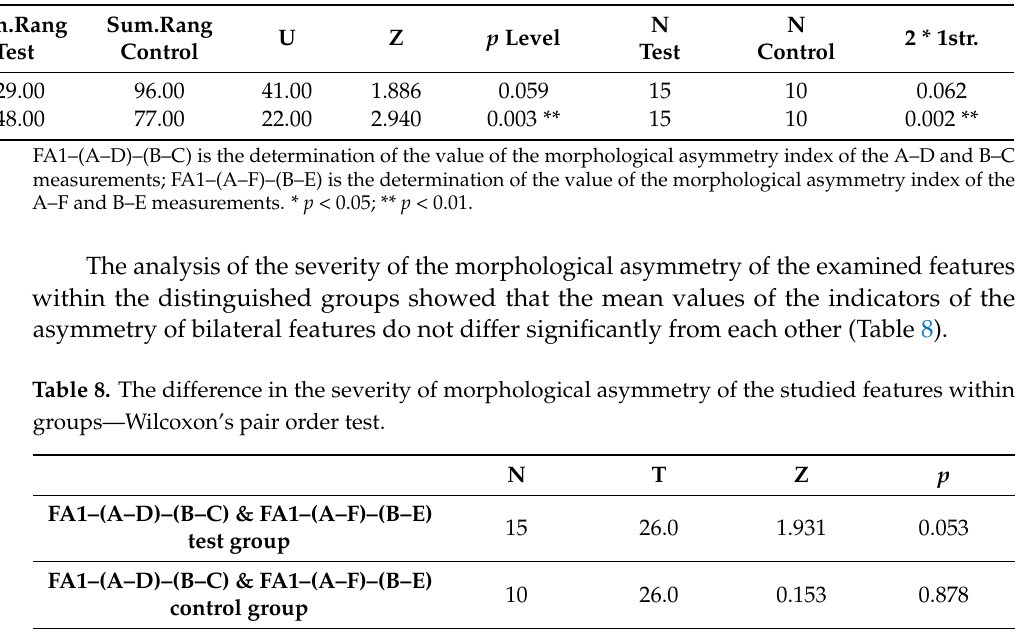
Table 7. The difference in the severity of morphological asymmetry of the examined features between the test group and the control group—the Mann–Whitney U test.